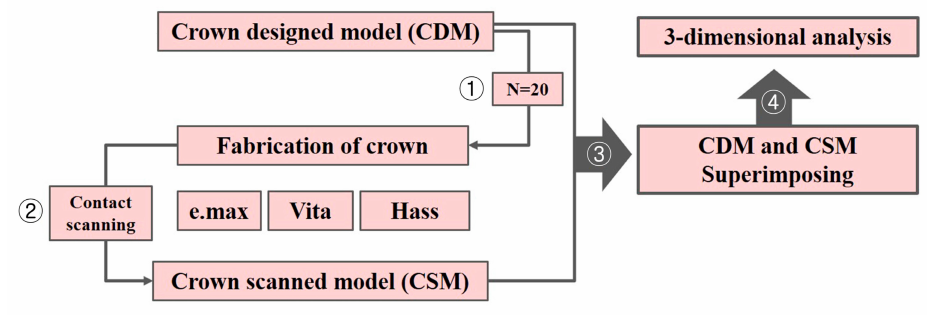
Figure 1. Experimental